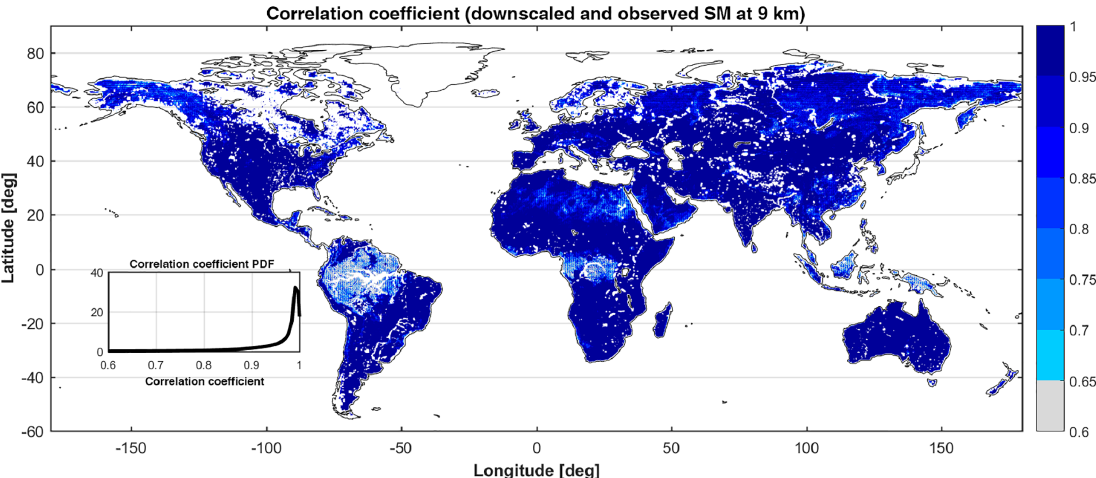
Figure 4. Correlation coefficient ( R 2 ) between SMAP-observed soil moisture (SM) at 9km and NN-downscaled soil moisture at 9km. White regions indicate no